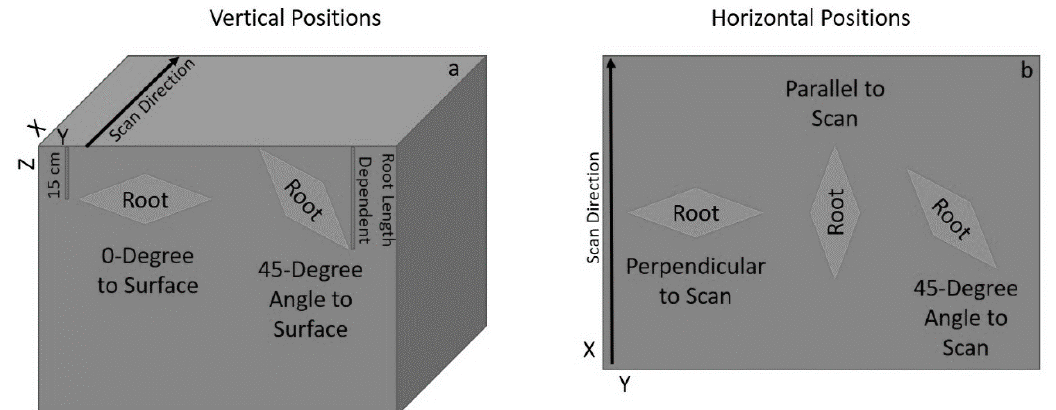
Figure 4. Illustration of root planting parameters: ( a ) 3D representation of the sandbox: Vertical position in relation to the surface (0-degree to surface and 45-degrees to surface). Roots at 0-degree to the surface were buried at 15 cm depth, while roots at 45-degrees to surface were buried starting at surface and continuing downward to the max depth dependent on root length. ( b ) Plan (Top) view of the sandbox: Horizontal position in relation to the scan direction. There were three root positions being perpendicular to the scan direction, parallel to the scan direction, and a 45-degree angle to the scan direction.